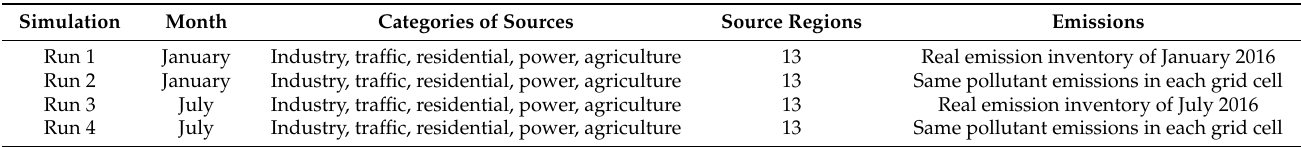
Table 1. Simulation design.